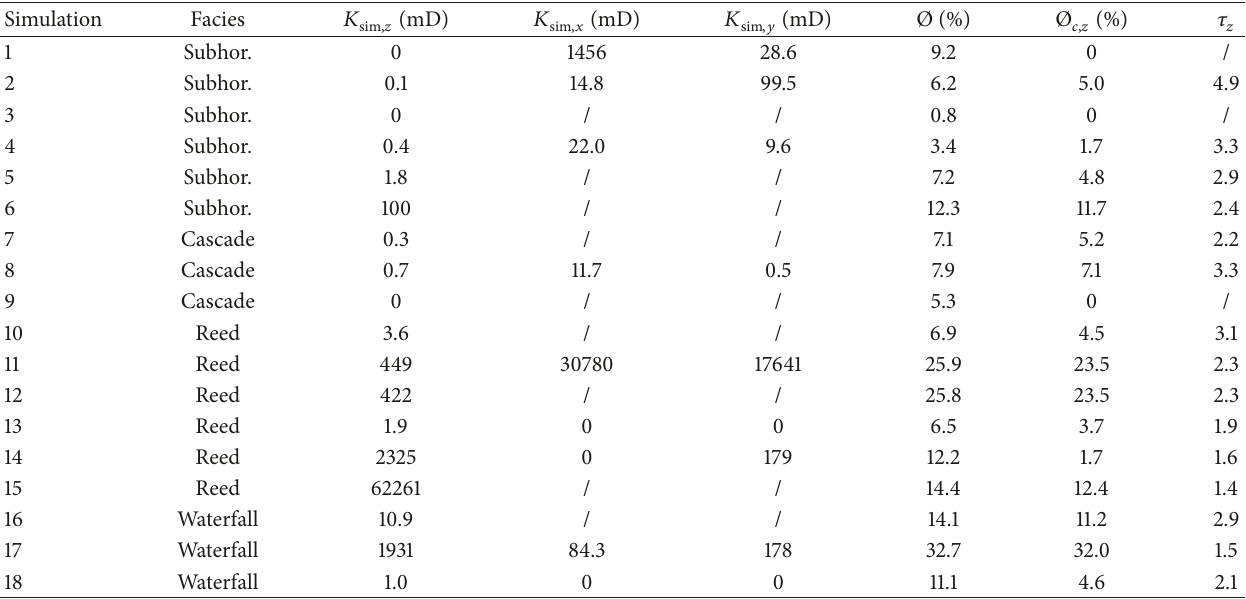
Table 2: Permeability simulations.